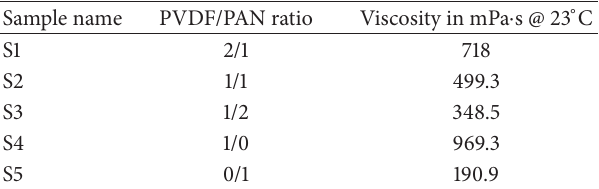
Table 1: Viscosity and mixing ratio of PVDF/PAN